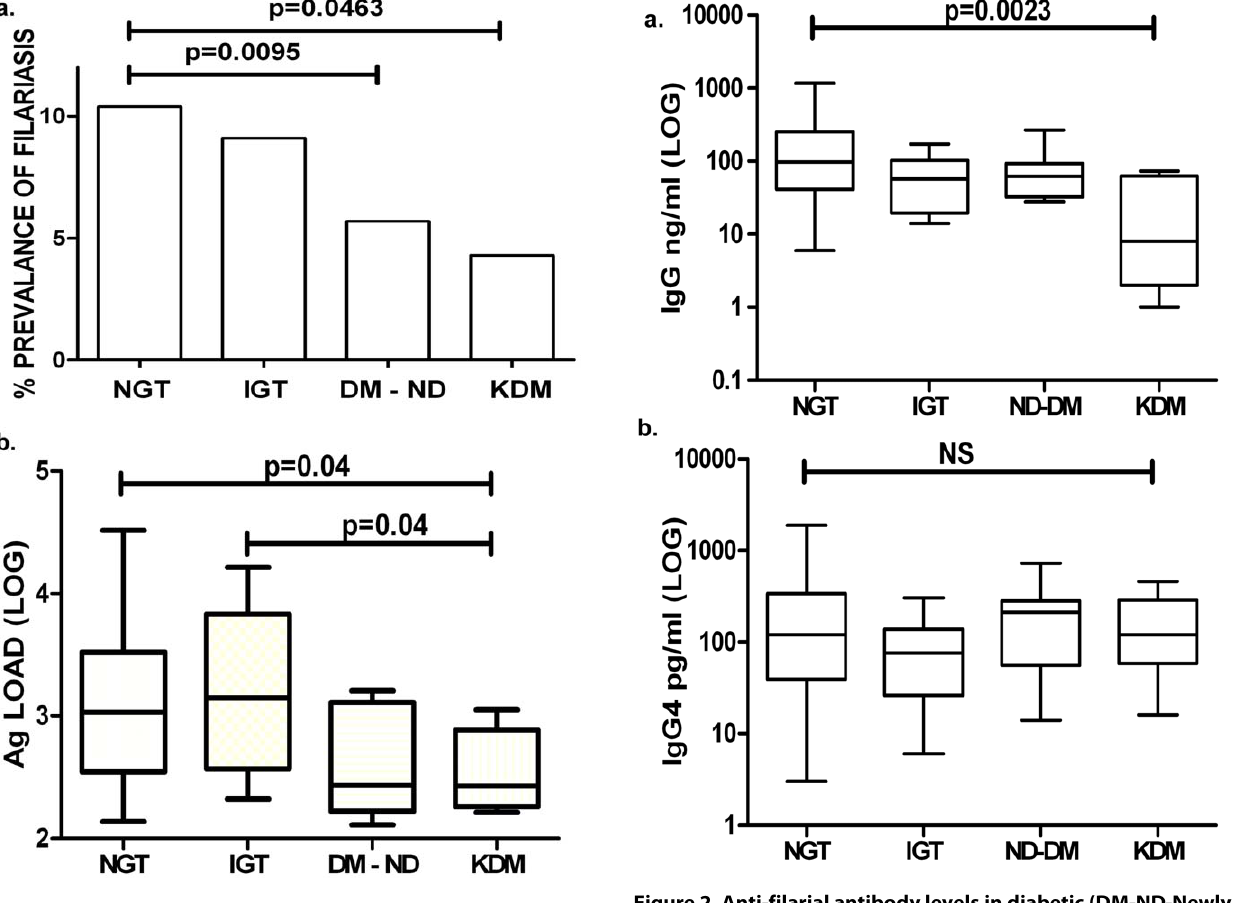
Figure 1. Reduced prevalence of Lymphatic Filariasis (LF) among diabetic individuals. Prevalence of filarial infection in diabetic (DM-ND-Newly diagnosed and KDM-Known diabetic) and non-diabetic (NGT-Normal glucose tolerance and IGT-Impaired glucose tolerance) subjects was estimated (Panel a). The percentage of LF positive individuals in each group is shown. Statistical difference in the prevalence was determined by chi-square analysis. Filarial antigen levels in diabetic (DM-ND-Newly diagnosed and KDM-Known diabetic) and non-diabetic (NGT-Normal glucose tolerance and IGT-Impaired glucose tolerance) subjects with active filarial infection (Panel b). Statistical differences in the antigenic load were determined by Mann-Whitney U test.